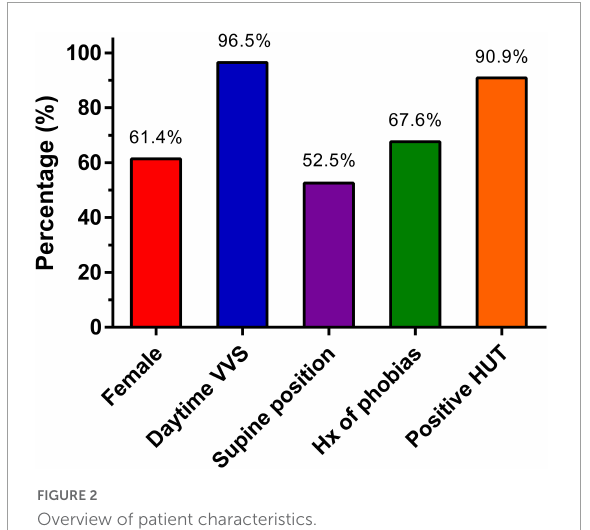
FIGURE2 Overview of patient